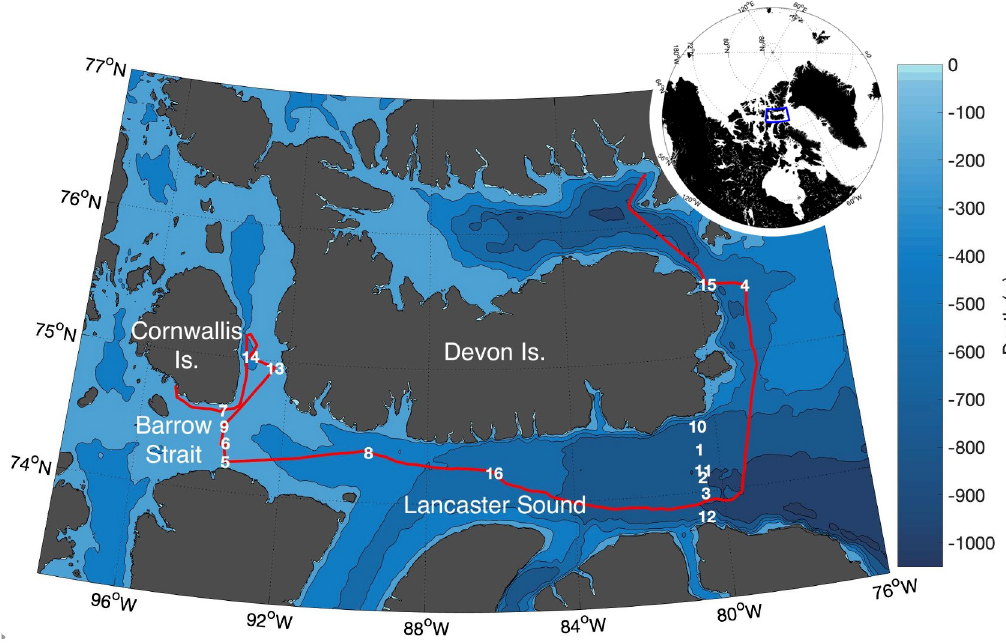
Fig 1. Study region map. The inset globe shows the geographic region of interest outlined in blue. The detailed map shows the numbered CTD stations sampled in August 2019, overlayed on bathymetric contours. We use the 200m bathymetric contour line around 92˚W to separate Lancaster Sound and Barrow Strait. The ship track is shown in red. The complete list of geographic coordinates sampled is available in the Polar Data Catalogue (doi: 10.5884/12715). The map was produced in Matlab (R2020a) using the publicly available m_map package [41].